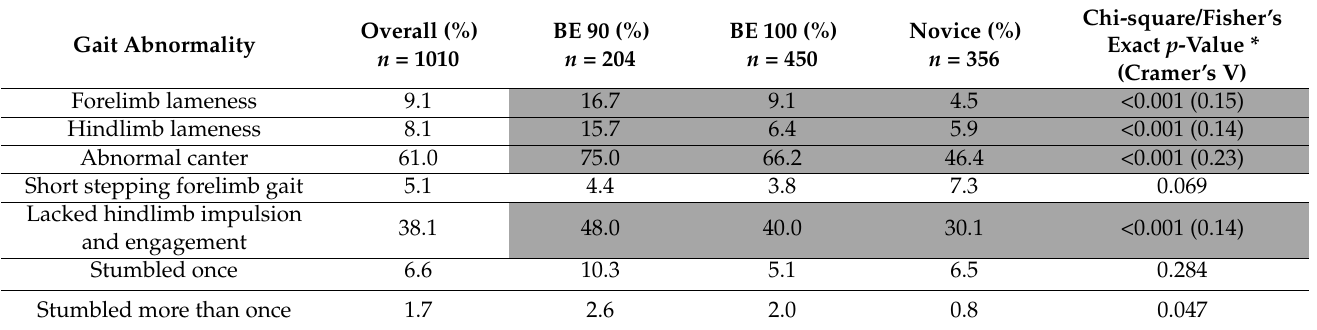
Table 1. The frequency of occurrence, expressed as a percentage of competition starts, of forelimb lameness, hindlimb lameness, abnormalities of canter, bilaterally short forelimb steps, a short stepping hindlimb gait which lacked hindlimb impulsion and engagement, stumbling once or stumbling more than once at British Eventing (BE) 90, 100 and Novice competitions. Significant differences among competition levels are highlighted in